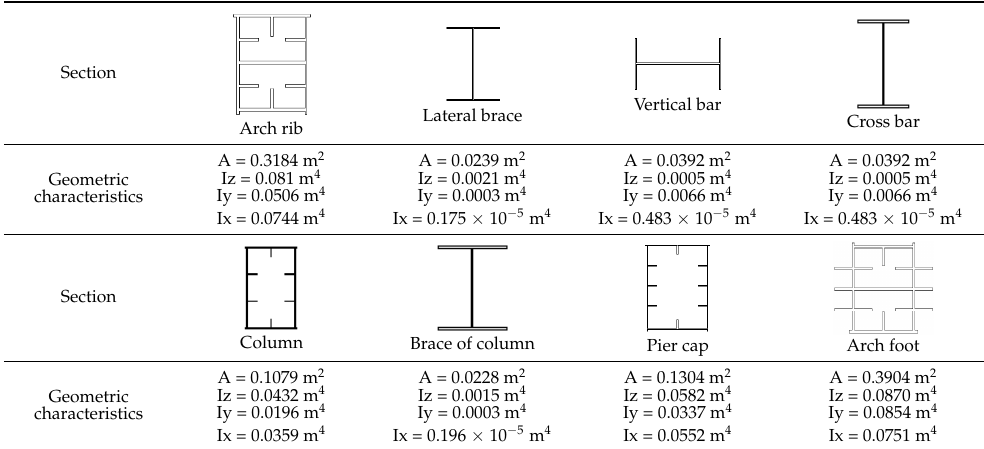
Figure 3. General layout of bridge. (unit:cm). Table 2. Section of members.